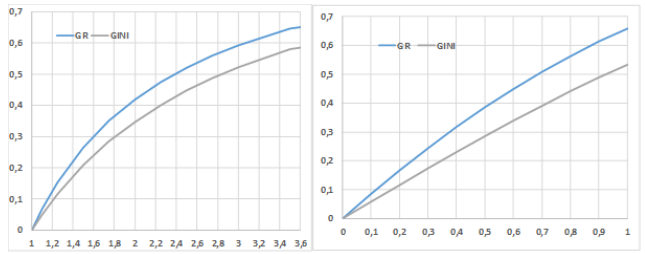
Figure 4. GR and GINI indicators. Source: own